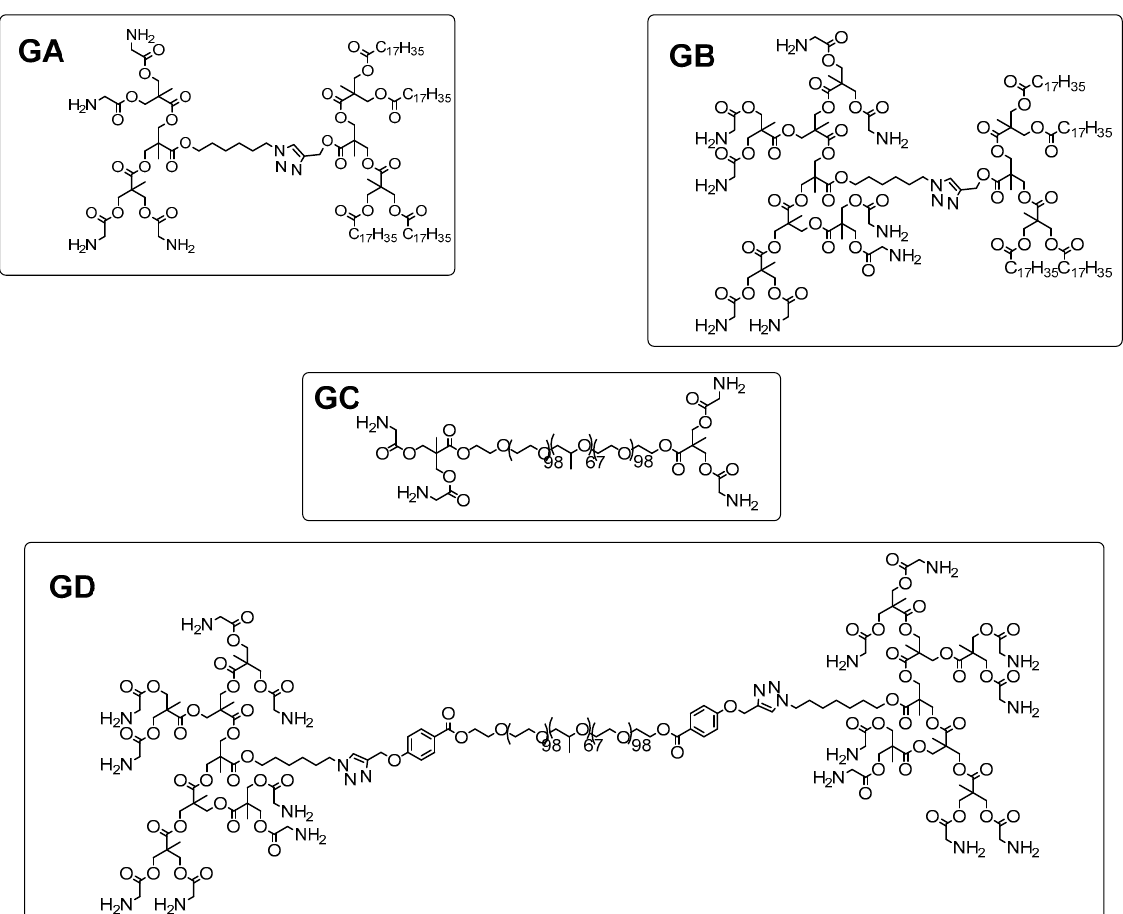
Figure 13. Janus dendrimer (with two different generations GA and GB) and hybrid dendritic-linear-dendritic block copolymers (with two different generations GC and GD) to of CQ, PQ and rhodamine B encapsulation [79] .